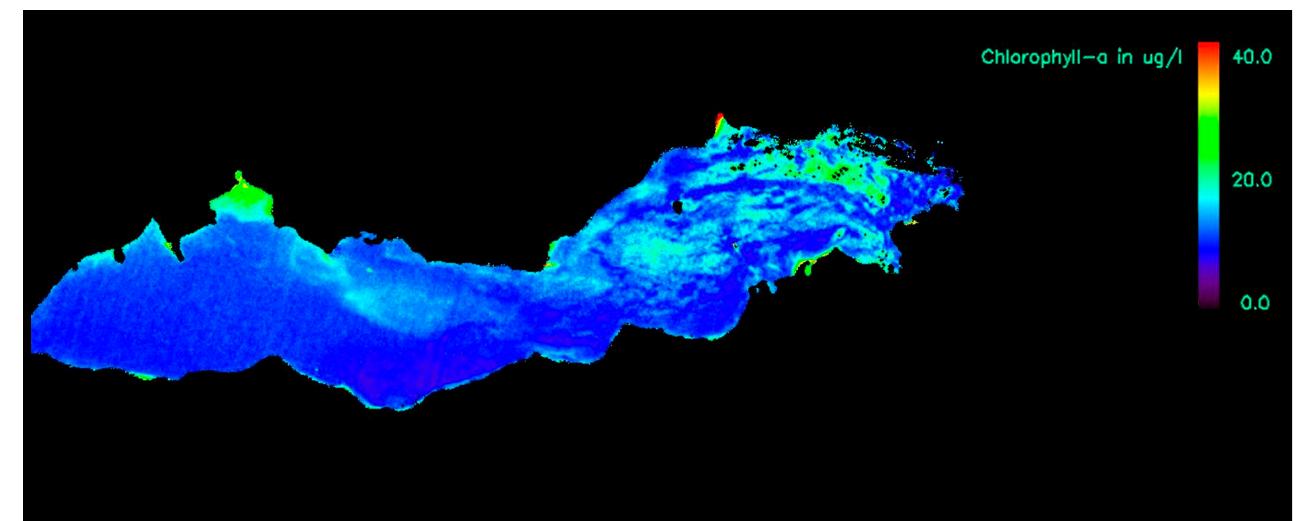
Figure 6. Visualization of chlorophyll a data [µg/l] for Varna Lake and Black Sea coastal area derived from processing of Sentinel-2 imagery on the iEMOWAF web